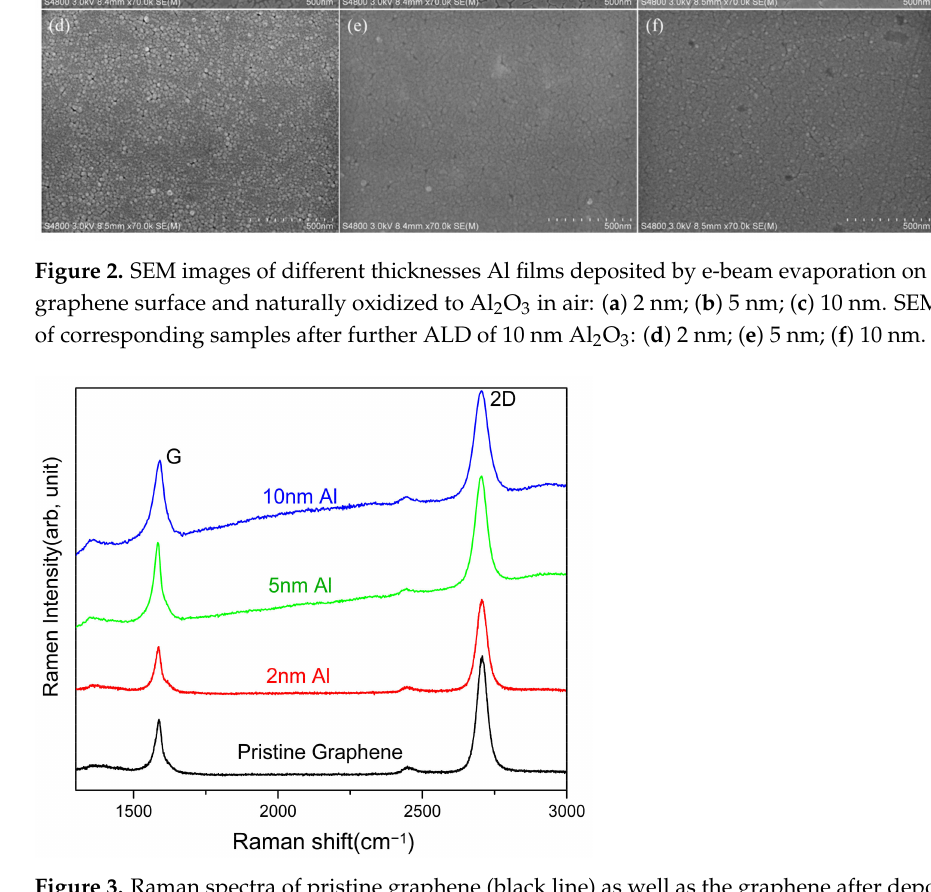
Figure 3. Raman spectra of pristine graphene (black line) as well as the graphene after deposition of 2 nm (red line), 5 nm (green line), and 10 nm (blue line) Al films by e-beam evaporation and natural oxidation to Al 2 O 3 seed layers in air,